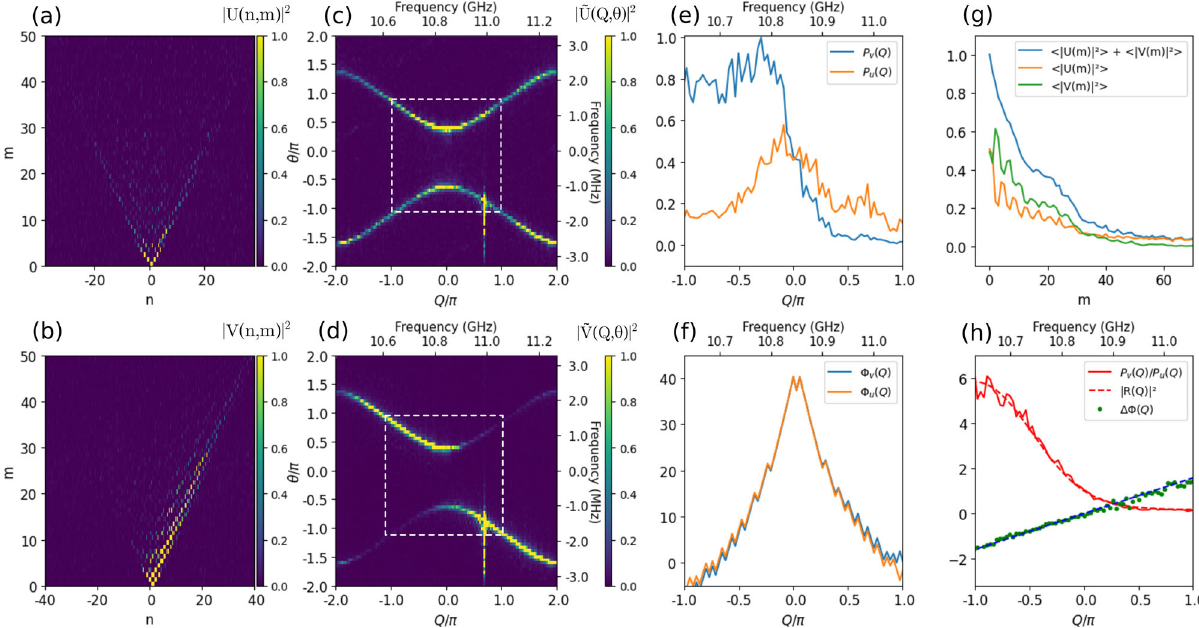
Fig. 5 Experimental results. Impulse responses were measured in the two loops ( a , b ) and their associated 2D Fourier transforms j ~ U ð Q ; θ Þj 2 ( c ) and j ~ V ð Q ; θ Þj 2 ( d ). The squares in white dashed lines in ( c , d ) represent the fi rst Brillouin zone. Experiments are made without applying any phase modulation in the U loop ( Φ ( m ) = 0 ∀ m ). e Spectral power distributions P U ð Q Þ ¼ j ~ U ð Q ; θ þ ð Q ÞÞj 2 (orange line) and P V ð Q Þ ¼ j ~ V ð Q ; θ þ ð Q ÞÞj 2 (blue line) measured along the upper spectral bands in ( c , d ). f Spectral phase distributions ϕ V ð Q Þ ¼ Arg ð ~ V ð Q ; θ þ ð Q ÞÞÞ (blue line) and ϕ U ð Q Þ ¼ Arg ð ~ U ð Q ; θ þ ð Q ÞÞÞ (orange line) measured along the upper spectral bands in ( c , d ). g Time evolution of the mean optical power in each loop: < ∣ U ( m ) ∣ 2 > = ∑ n ∣ U ( n , m ) ∣ 2 (orange line), < ∣ V ( m ) ∣ 2 > = ∑ n ∣ V ( n , m ) ∣ 2 (green line) and time evolution of the global power in the two loops < ∣ U ( m ) ∣ 2 > + < ∣ V ( m ) ∣ 2 > (blue line). h Ratio between the spectral power distributions P V ( Q )/ P U ( Q ) (red line) measured in the upper bands and evolution of the ratio ∣ R ( Q ) ∣ 2 (red dashed line) between the power of the Floquet – Bloch eigenmodes (see Eq. (5)). The spectral phase difference Δ ϕ ( Q ) = ϕ V ( Q ) − ϕ U ( Q ) computed from the data shown in ( f ) is plotted in green dots. It follows a simple linear relation given by Δ ϕ ( Q ) = Q /2 that complies with the fact that Arg( R ( Q )) = Q /2 (blue dashed